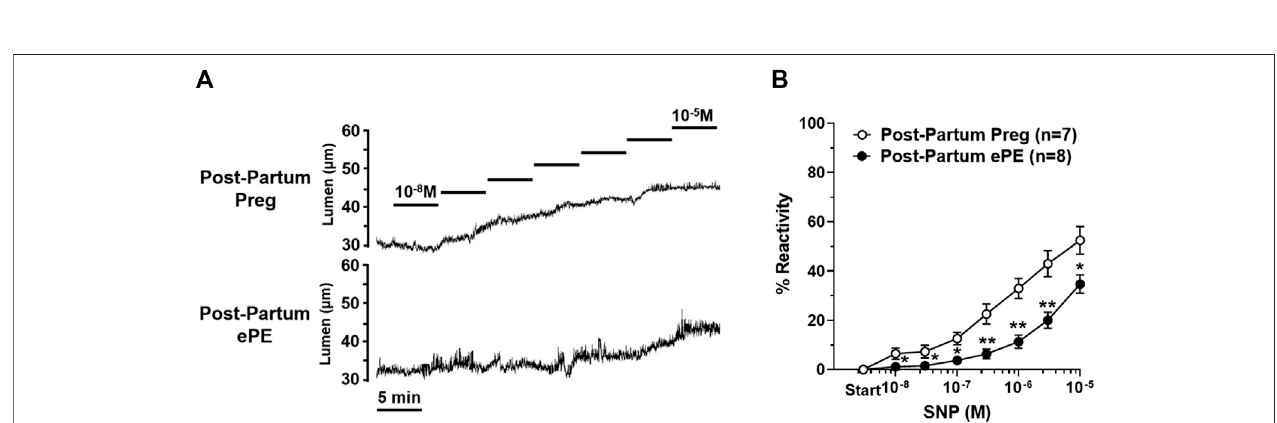
FIGURE 5 | Reactivity of hippocampal arteriole (HA) vascular smooth muscle to nitric oxide (NO). (A) Representative lumen diameter tracings of HAs from a Post- Partum Preg rat and a Post-Partum ePE rat during the concentration response curve to NO donor SNP. (B) HAs from rats that had ePE were less vasoreactive to increasing concentrations of SNP compared to arterioles from Post-Partum Preg rats. Data are mean ± SEM, ** p < 0.01; * p < 0.05 by Mann-Whitney test.